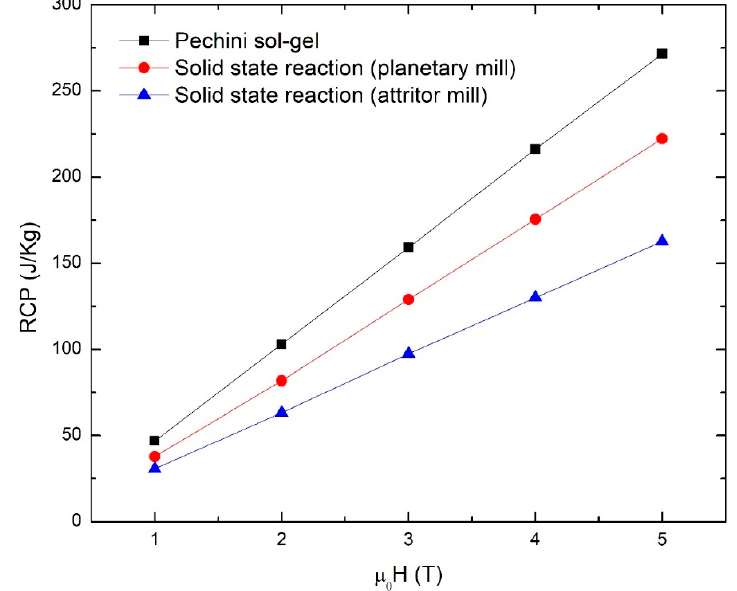
Figure 8. Relative cooling power (RCP) as a function of the magnetic field change of manganites manufactured by Pechini sol-gel, solid-state reaction with planetary mill, and solid-state reaction with attrition mill.